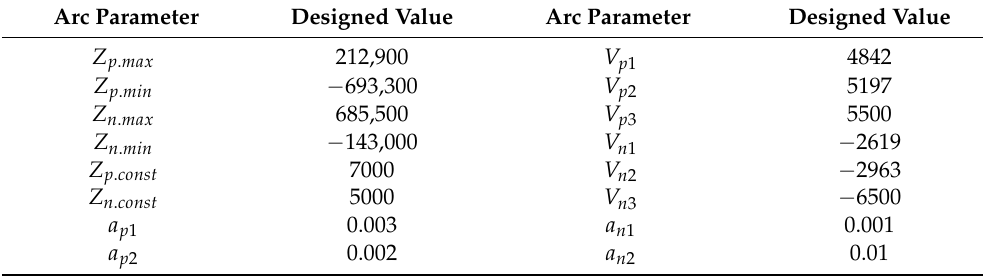
Table 1. Arc parameters used in the simulations. (Unit: impedance: [ Ω ], voltage: